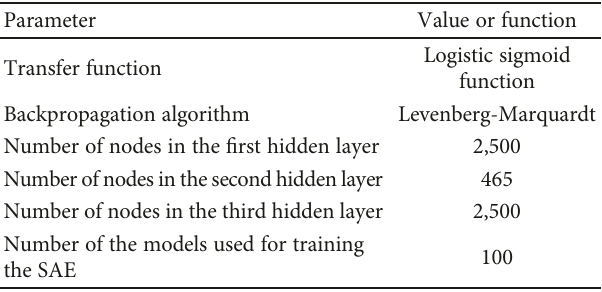
Table 6: Experimental settings for the